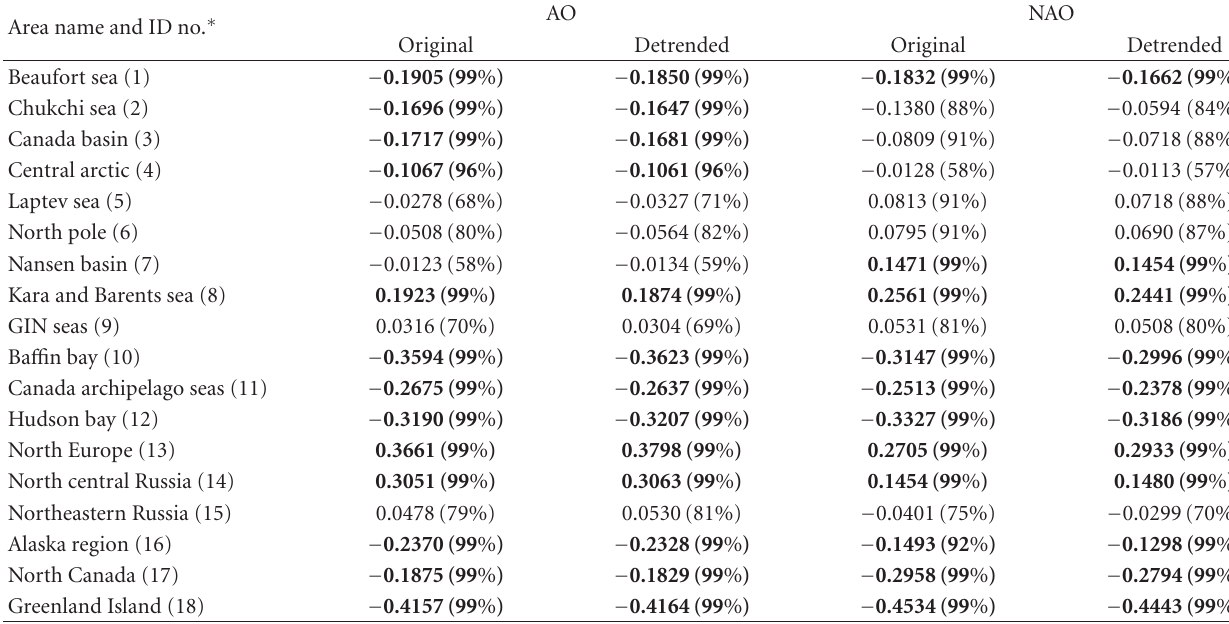
Table 3: Correlation between surface skin temperature anomalies and AO/NAO indices for the 18 Arctic sub-regions based on 276 months. Area name and ID no.